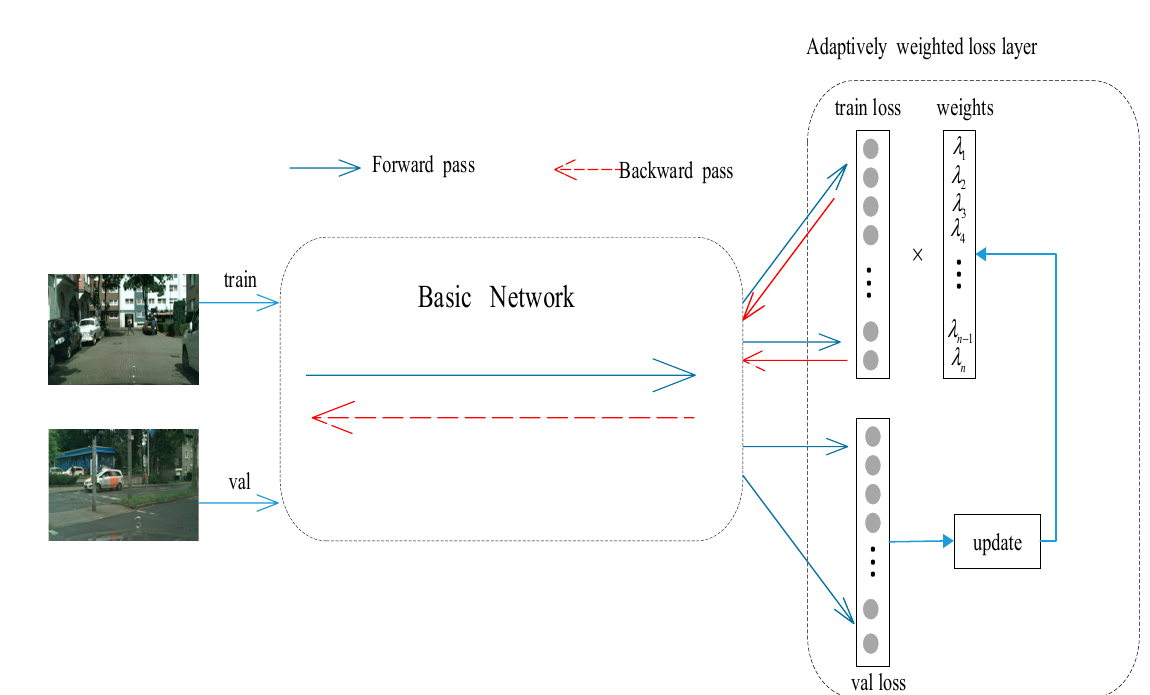
Figure 1. The structure diagram of the weight learning method of the adaptive weight loss layer.